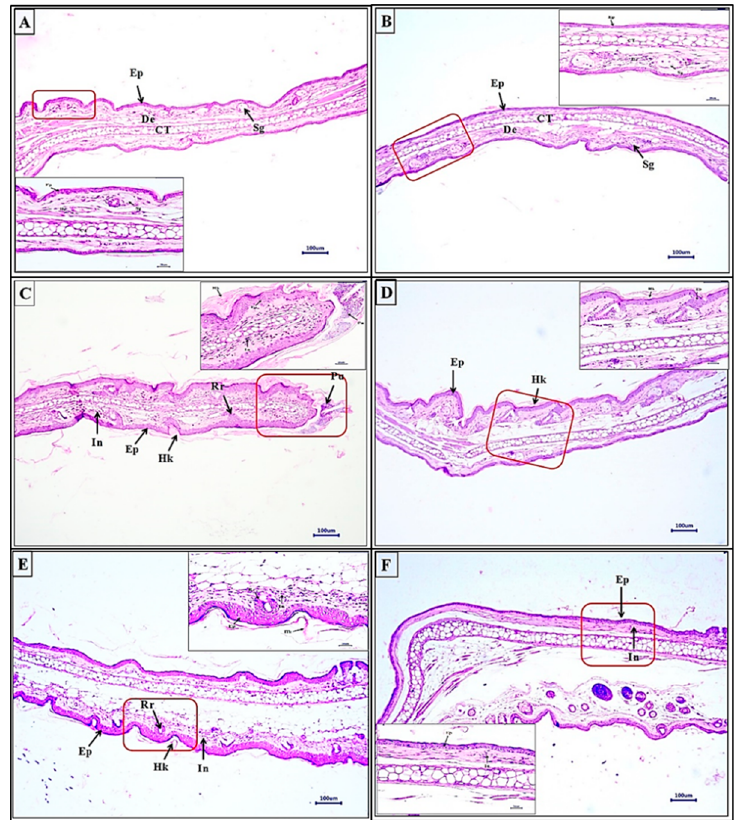
Figure 6. Histopathological analysis of ear biopsy from TPA-induced psoriasis-like mice model: Section of ear tissue samples were stained with H&E, ( A ) Negative control displays normal skin similar to vehicle control ( B ) with normal epidermis (Ep), dermis (De), sebaceous gland (Sg), cartilage (CT). In ear tissue of ( C ) TPA-induced psoriasis, prominent changes were observed with the presence of hyperkeratosis (Hk) and hyperplastic epidermis (Ep), inflammatory cells (In), with rete ridge (Rr) and pustule (Pu) formation. Decrease in both number and severity of these hallmarks were observed with 410 mg/kg + 20 µL T.A. ( E ) and 1230 mg/kg + 20 µL T.A. ( F ) of WSSO treatments. Dexamethasone ( D ) also significantly reduced psoriasis-like symptoms. Higher magnification images (inset) are displayed, scale bar represents 100 and 20 µm for low and high magnification images.